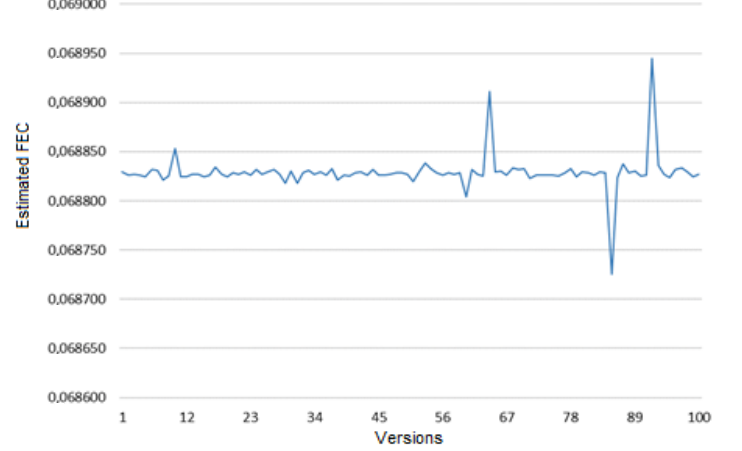
Figure 15. Estimated final FEC values.